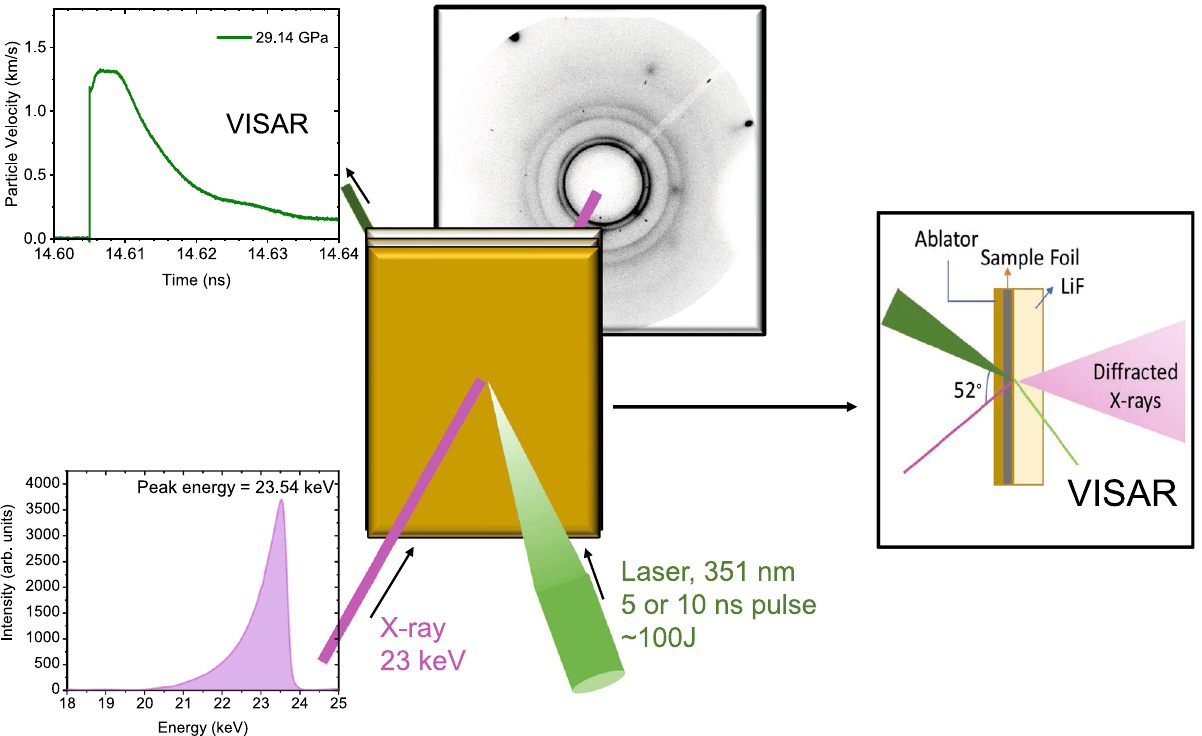
Figure 1. Experimental configuration arranged in a transmission geometry at the DCS laser station showing the pink (non-monochromatic) beam profile of the U17 undulator x-ray source, together with XRD diffraction ring from the Sm sample and processed point-VISAR data collected at the Sm/LiF interface (time zero corresponds drive laser impact). Bright spots correspond to reflection from LiF single crystal. The target assembly consists of kapton ablator backed by Sm foil, which is backed by a LiF